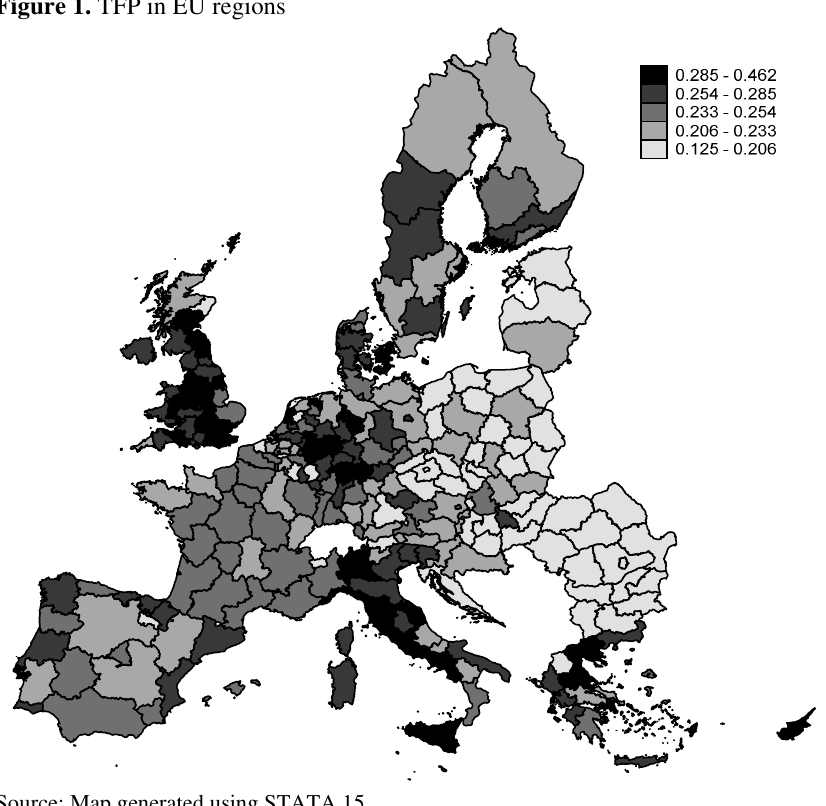
Source: Map generated using STATA